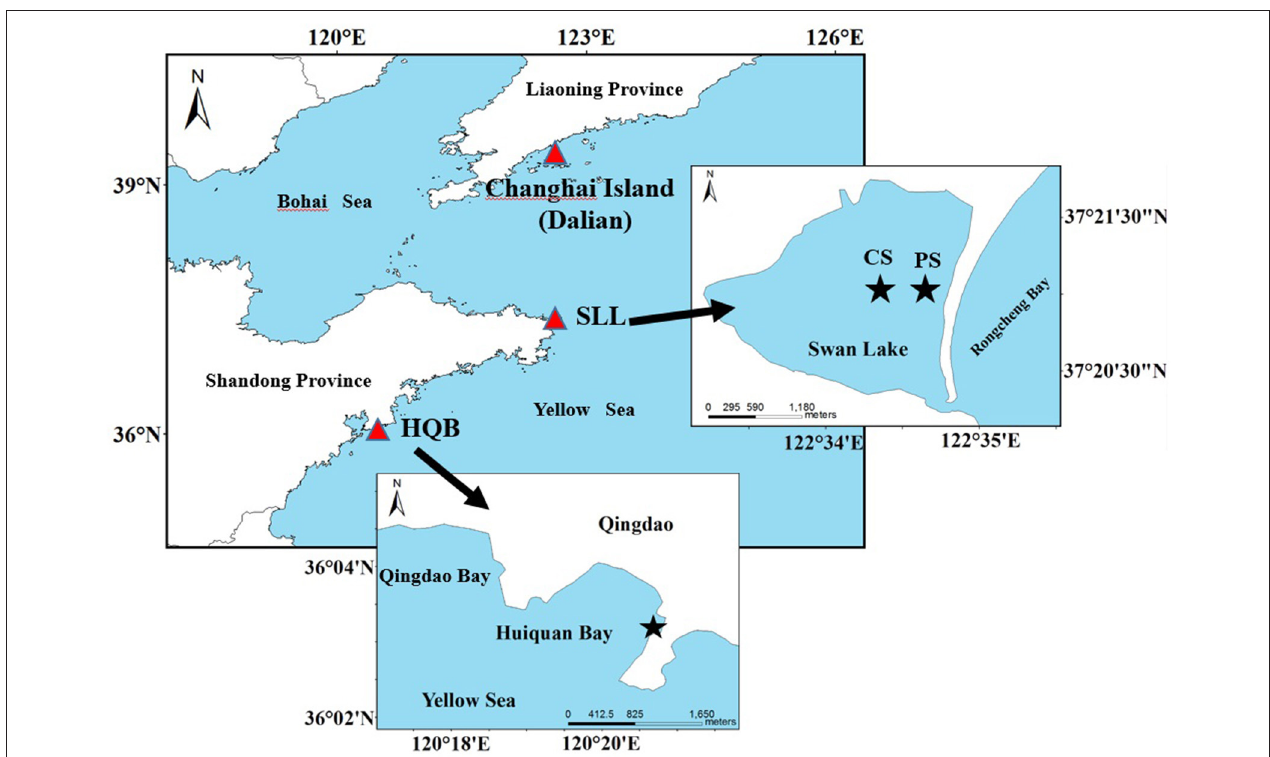
FIGURE 1 | Zostera marina study sites of Swan Lake (SLL) and Huiquan Bay (HQB) as well as location of Changshan Island (Dalian). Red triangular symbols represent the locations of seagrass beds. CS (Center site) and PS (Patch site) represent the center of continuous distributed area and patch area of eelgrass in SLL,